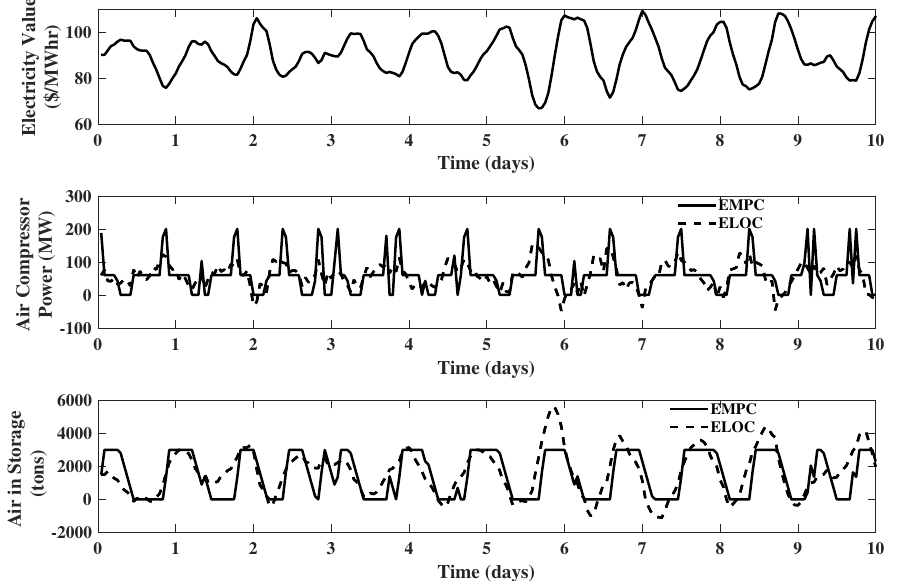
Figure 12. Comparison of EMPC and ELOC policy for Example 9: air compressor power consumption and compressed air